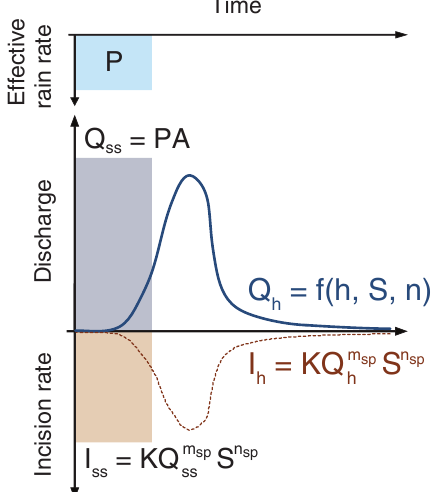
Figure 1. Image illustrating the differences between steady-state and non-steady hydrology and incision at a single point within a watershed. In this schematic, the effective precipitation rate ( P ) is the same for both steady and non-steady cases. During the precipi- tation event, steady discharge ( Q ss ) and incision rate ( I ss ) are con- stant, driven by that effective precipitation rate and drainage area ( A ), erodibility ( K ), water surface slope ( S ), and stream power ex- ponents ( m sp , n sp ). In the non-steady case, a wave front begins to propagate and incise, producing time-varying discharge ( Q h ), cal- culated using physical parameters such as water depth ( h ), water surface slope ( S ), and Manning’s roughness coefficient ( n ). Non- steady incision rate ( I h ) is calculated using the time-varying dis- charge, erodibility, and water surface slope. At the end of the pre- cipitation event, Q ss and I ss also end, while non-steady values Q h and I h continue until all water has completely exited the system at the